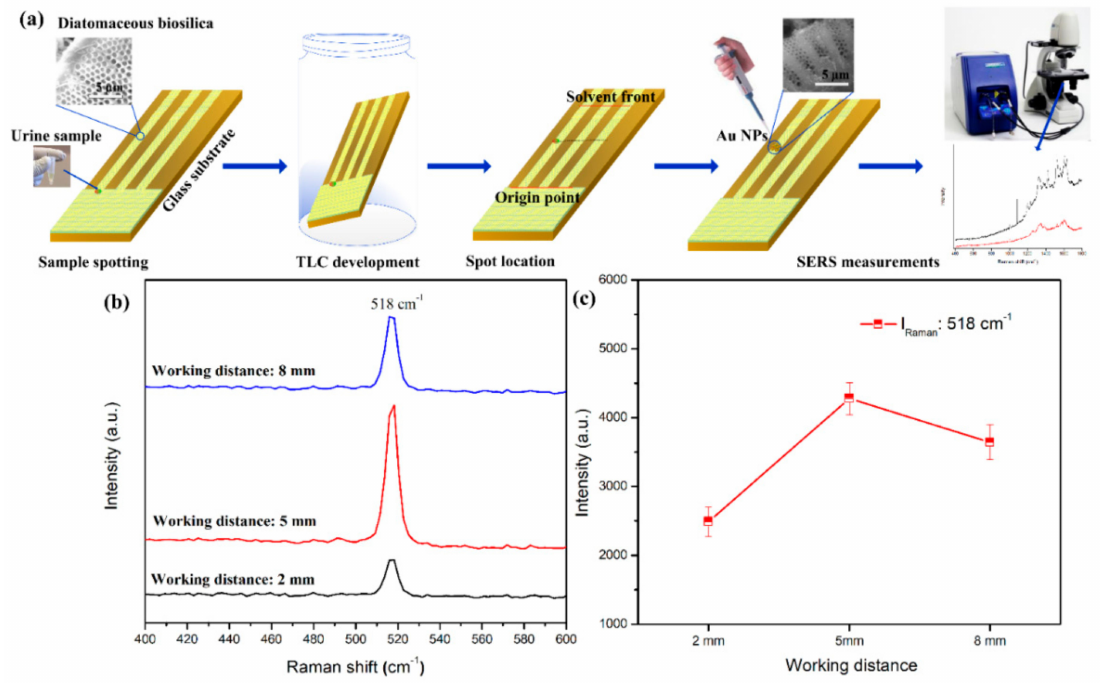
Figure 1. ( a ) Process of TLC-SERS detection of THC from urine samples via a portable Raman spectrometer. ( b ) The Raman spectra of a Si wafer at various working distances from the fiber tip, and ( c ) intensities versus di ff erent working distances using the I Raman peak at 518 cm − 1